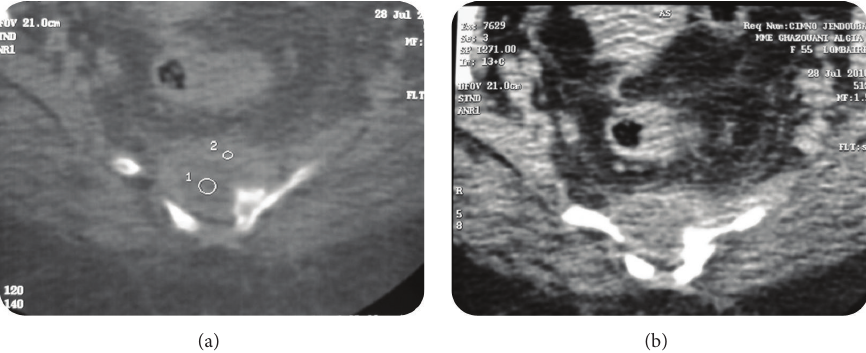
Figure 2: Contrast-enhanced computed tomography (CT) scans of the patient revealing presacrococcygeal lytic